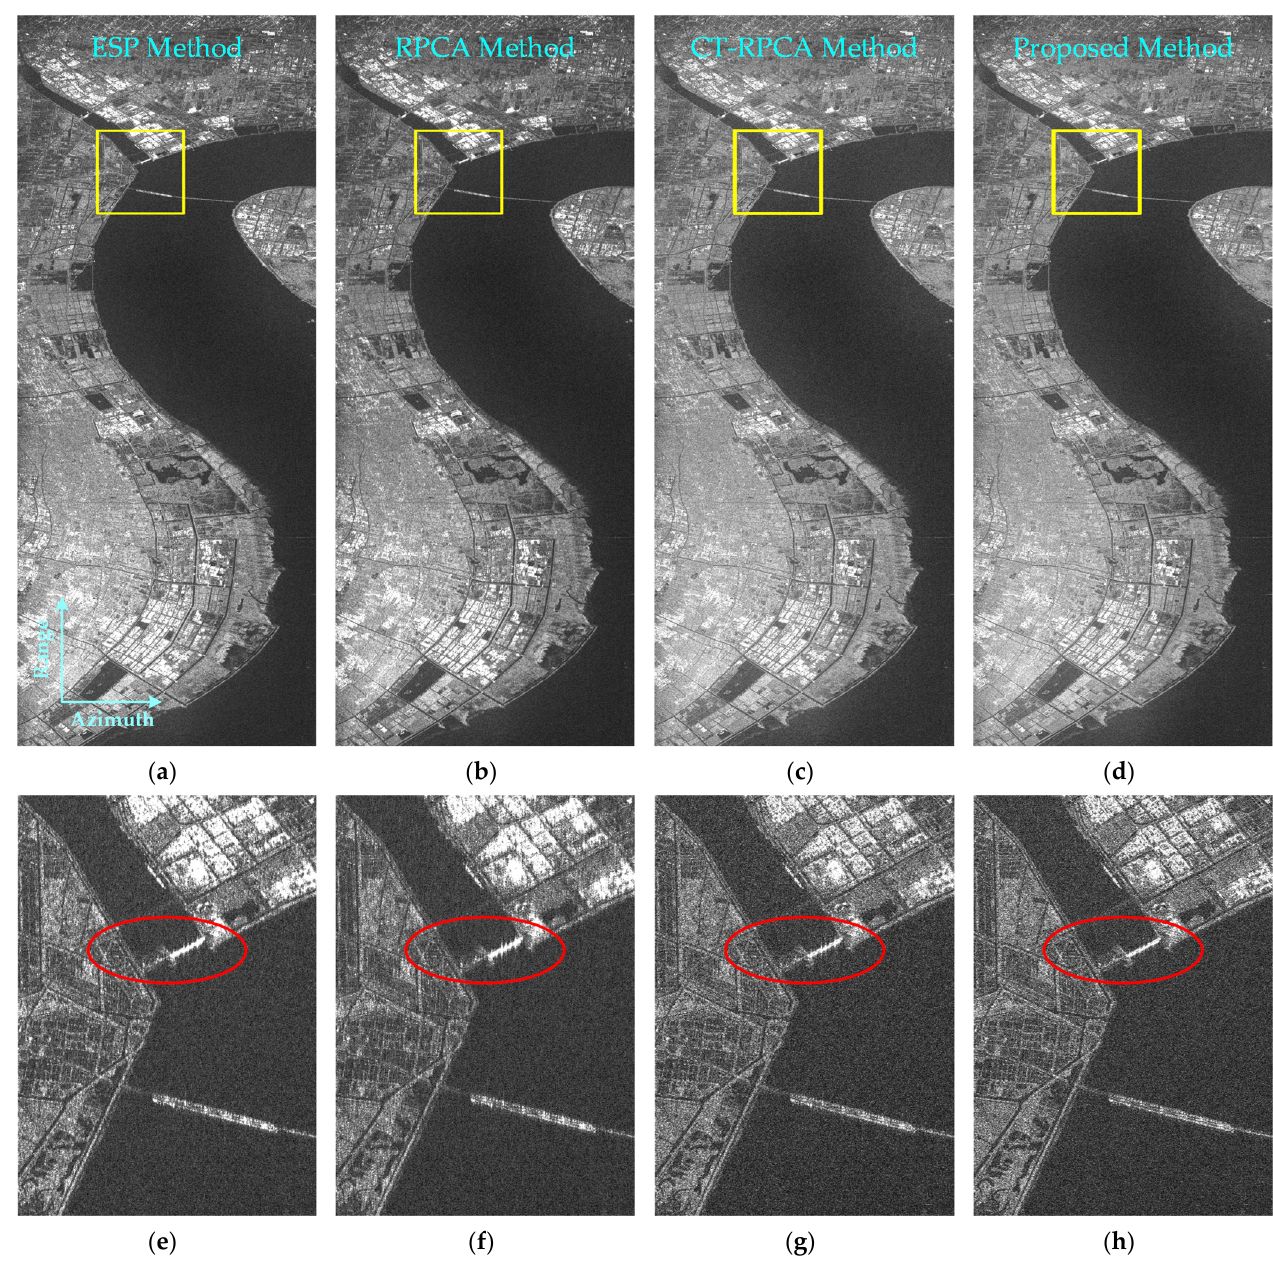
Figure 11. Experimental results for Sentinel-1 level-0 raw data: ( a ) Mitigation result by the ESP method; ( b ) Mitigation result by the RPCA method; ( d ) Mitigation result by the CT-RPCA method; ( c ) Mitigation result by the proposed approach; and ( e – h ) ROIs with the yellow box in ( a – d ).